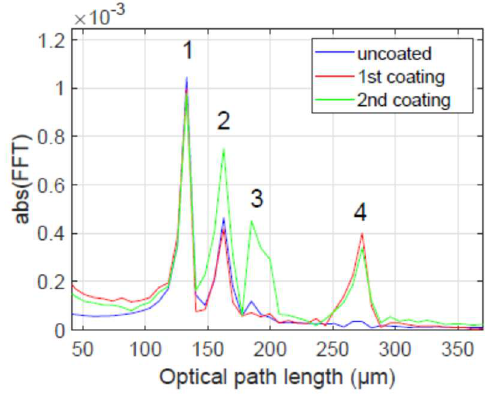
Fig. 3. Calculated FFT of the measured reflection spectra of the sensor with different configurations of coatings while immersed in DI water: no coating (blue), coating on the side walls of FPR4 (red) and additional FPR3 (green).